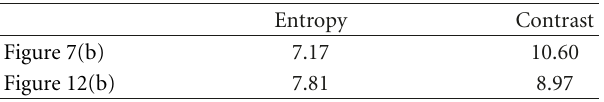
Table 4: Focusing indicators for the simulated ISAR images in Figures 7(b) and